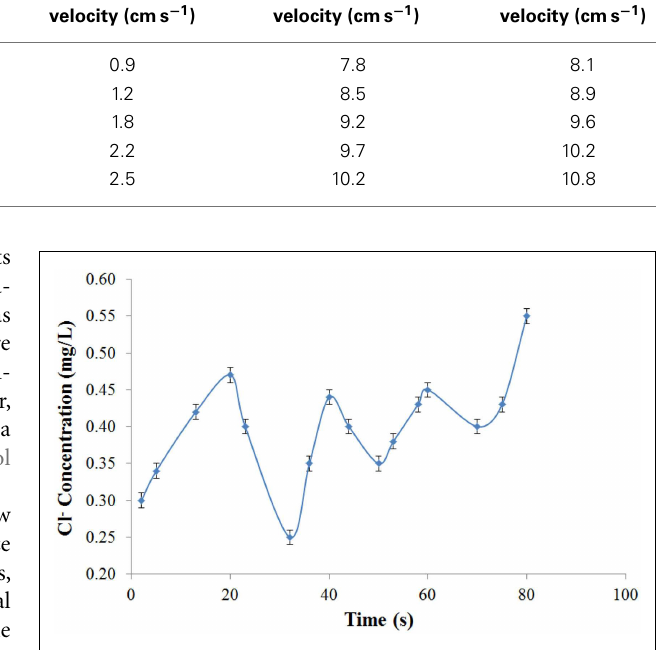
FIGURE 5 | Circulation test in the bioreactor